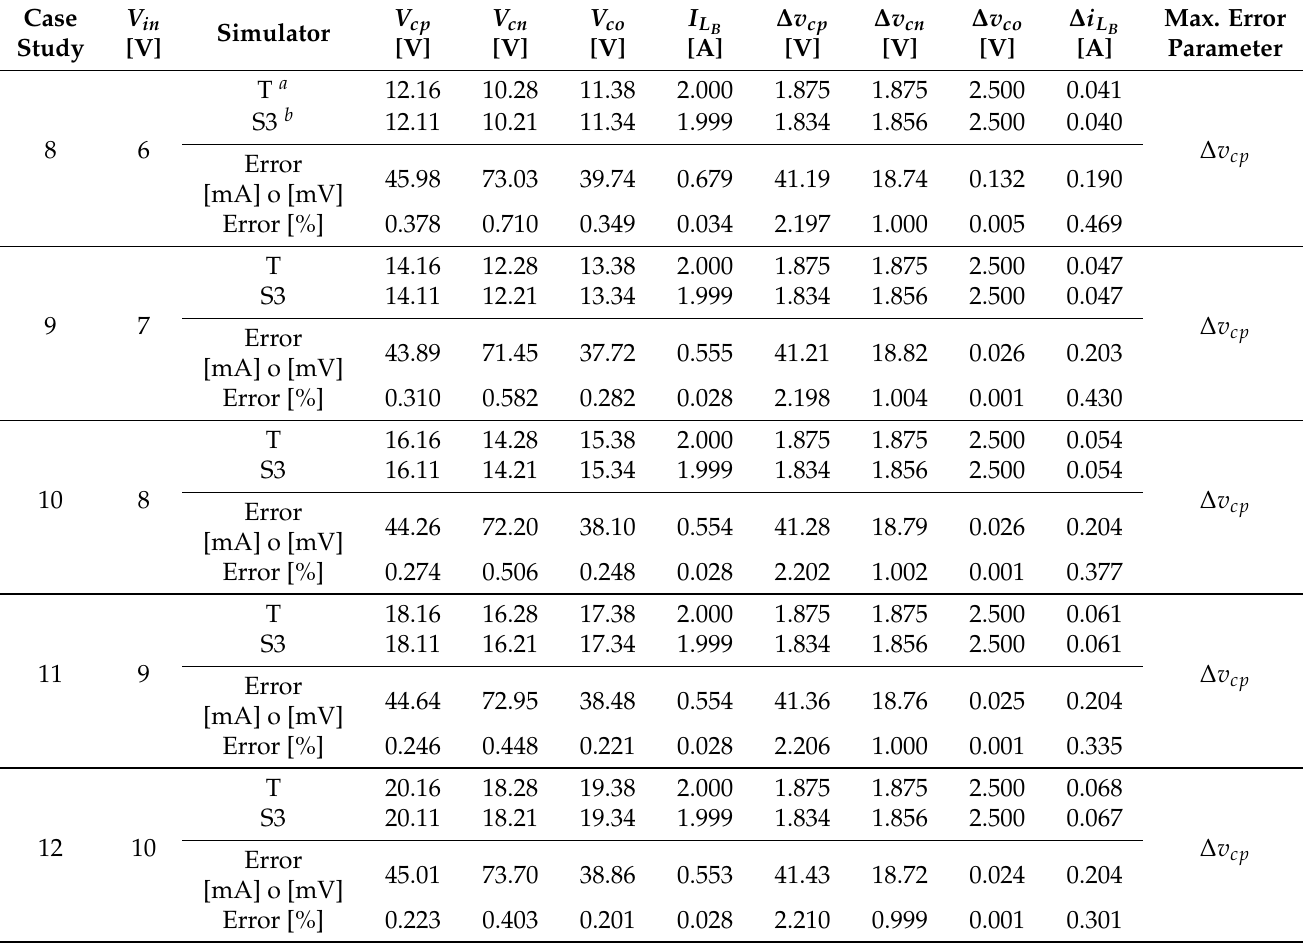
Table 7. Theoretical and simulated values of the converter with Input voltage variation.